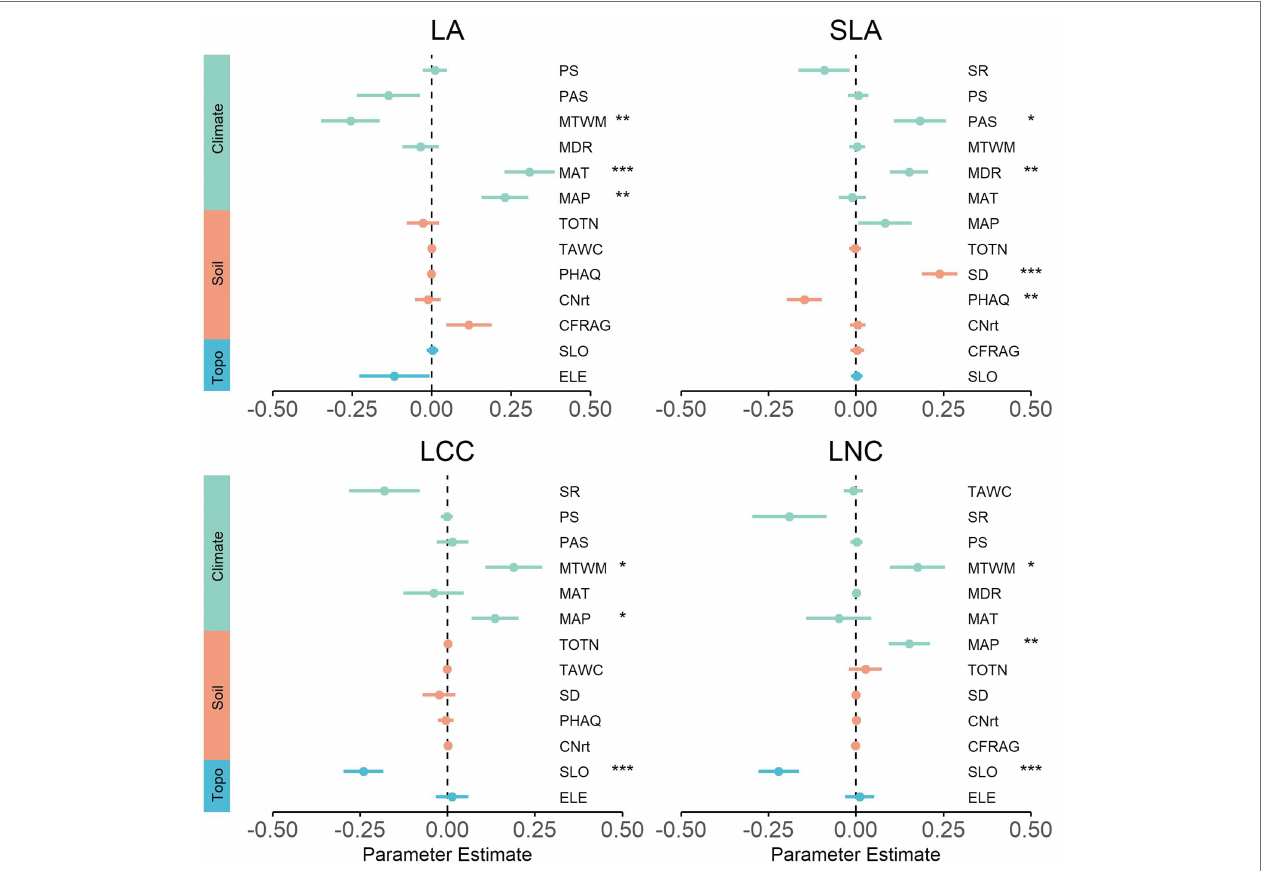
FIGURE 5 | Effects of environmental variables on community functional composition for the regional scale. We show the averaged parameter estimates (standardized regression coefficients) of model predictors and the associated 95% confidence intervals. The p -value of each predictor are given as: (.), p < 0.1; * p < 0.05; ** p > 0.01; *** p < 0.001. MAT, mean annual temperature; MDR, mean diurnal range; MTWM, max temperature of warmest month; MAP, mean annual precipitation; PS, precipitation seasonality; PAS, precipitation as snow; SR, solar radiation; CFRAG, coarse fragments; TAWC, volumetric water content; TOTN, total nitrogen content; CNrt, C/N ratio; PHAQ, pH in water; SD, soil depth; ELE, elevation; SLO,